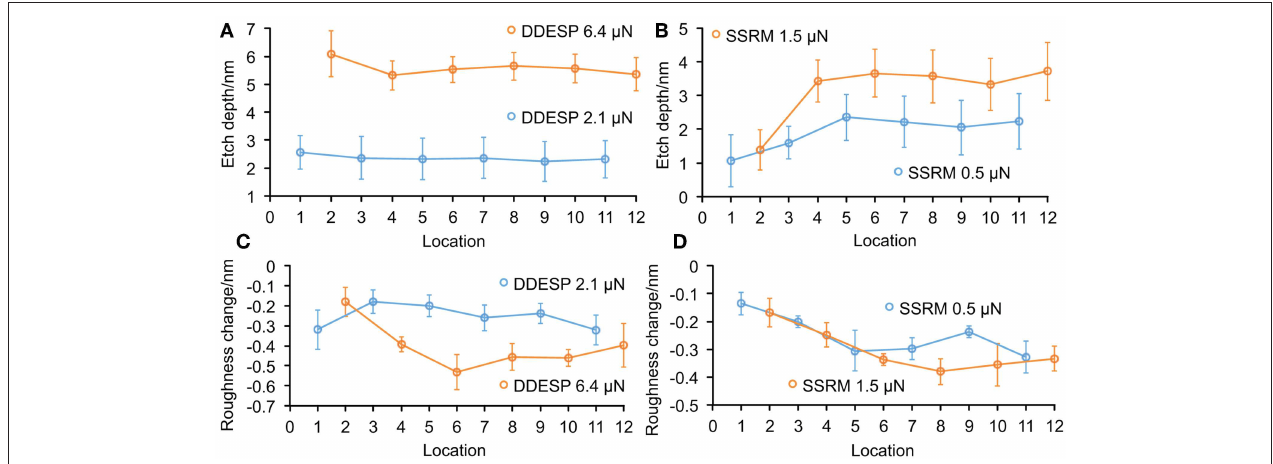
FIGURE 1 | The effect of probe history on the consistency of etching processes on SiO x . (A,B) Etch depths at each location for the diamond-coated (DDESP) and full-diamond (SSRM) probes, respectively. The etch depth initially decreases for the diamond-coated probe, whereas it increases for the full-diamond probe. (C,D) Trench roughness change for the diamond-coated and full-diamond probes, respectively. The trenches become smoother with probe use.